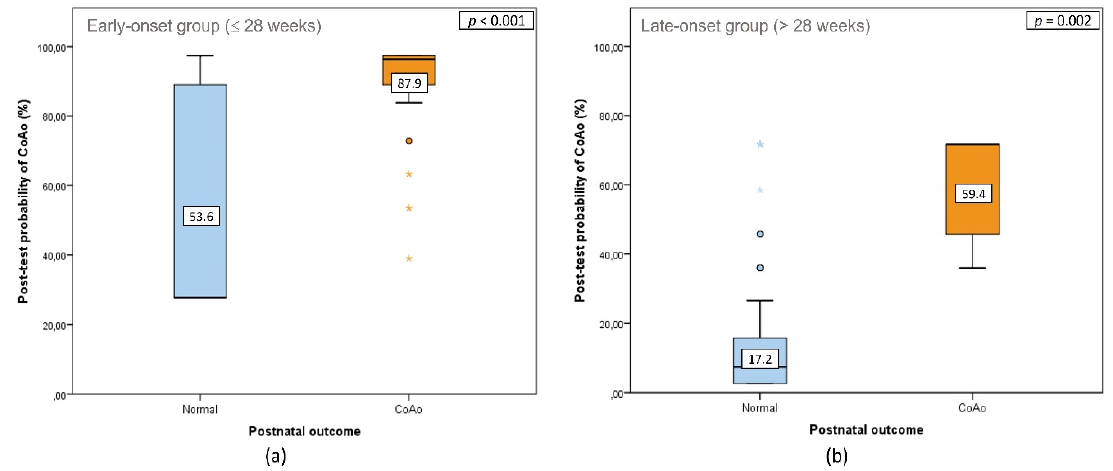
Figure 5. Box-and-whisker plots illustrating the distribution of post-test probability in 68 fetuses with suspected coarctation of the aorta (CoAo) diagnosed at ≤ 28 weeks ( a ) and 111 at >28 weeks ( b ), according to postnatal outcome. Solid horizontal lines inside boxes correspond to median values, while the interquartile range (IQR) is represented by boxes. Whiskers show range. Values beyond 1.5 IQR from 25th and 75th centiles are shown by extreme points. Numbers in boxes indicate mean values.